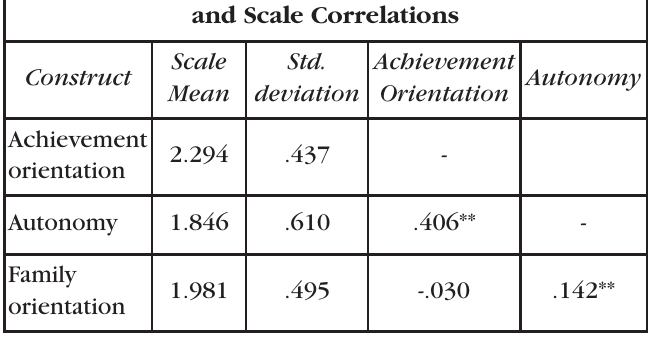
Table 1. Means, Standard